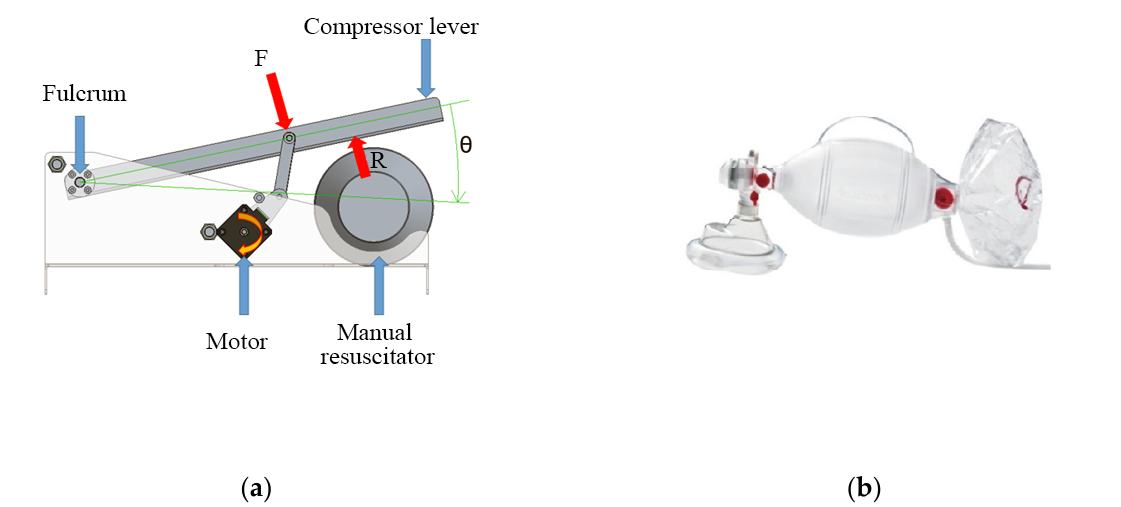
Figure 4. Conceptual design of the automation system of a manual respirator. ( a ) Mechanism based on a four-bar linkage; ( b ) Ambu Spur II manual